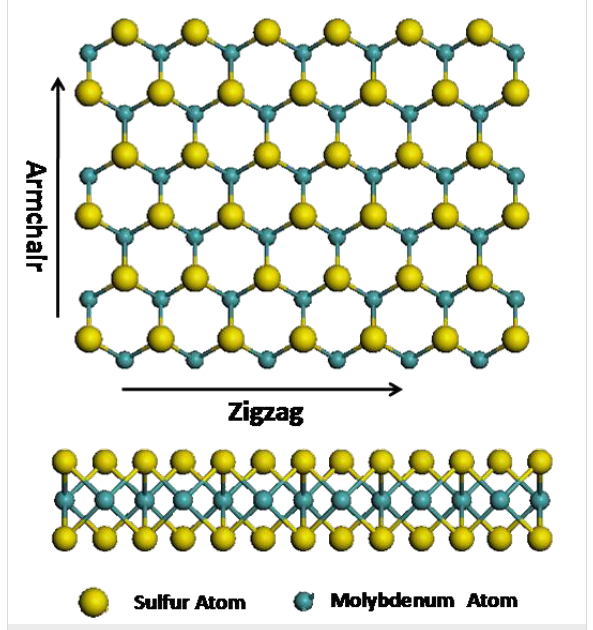
Figure 1: The atomic structure of a defect-free MoS 2